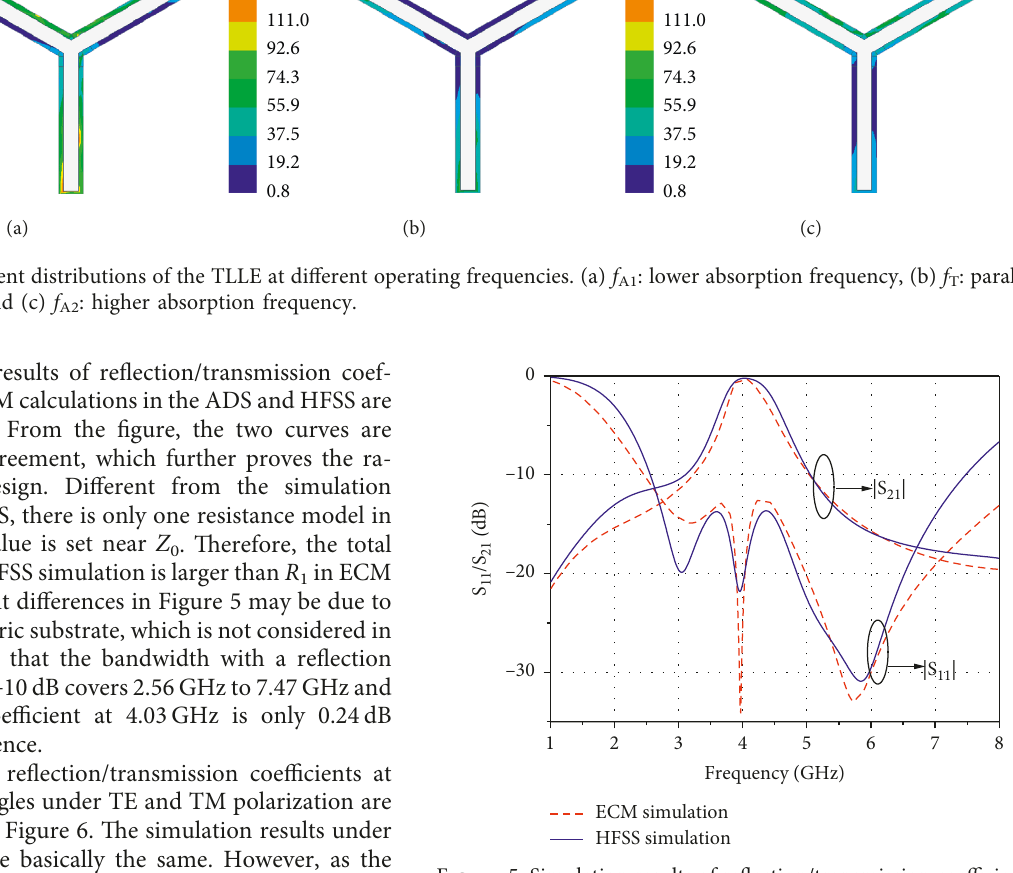
Figure 5: Simulation results of reflection/transmission coefficients based on ECM calculations and HFSS (circuit parameters: L 1 � 3.81 nH, C 1 � 0.203 pF, R 1 � 390 Ω , L 2 � 5.05 nH, C 2 � 0.633 pF, R 2 � 0.5 Ω , L 3 � 2.123 nH, C 3 � 0.757 pF, and h � 13mm, for which the corresponding electrical length is 64 ° at